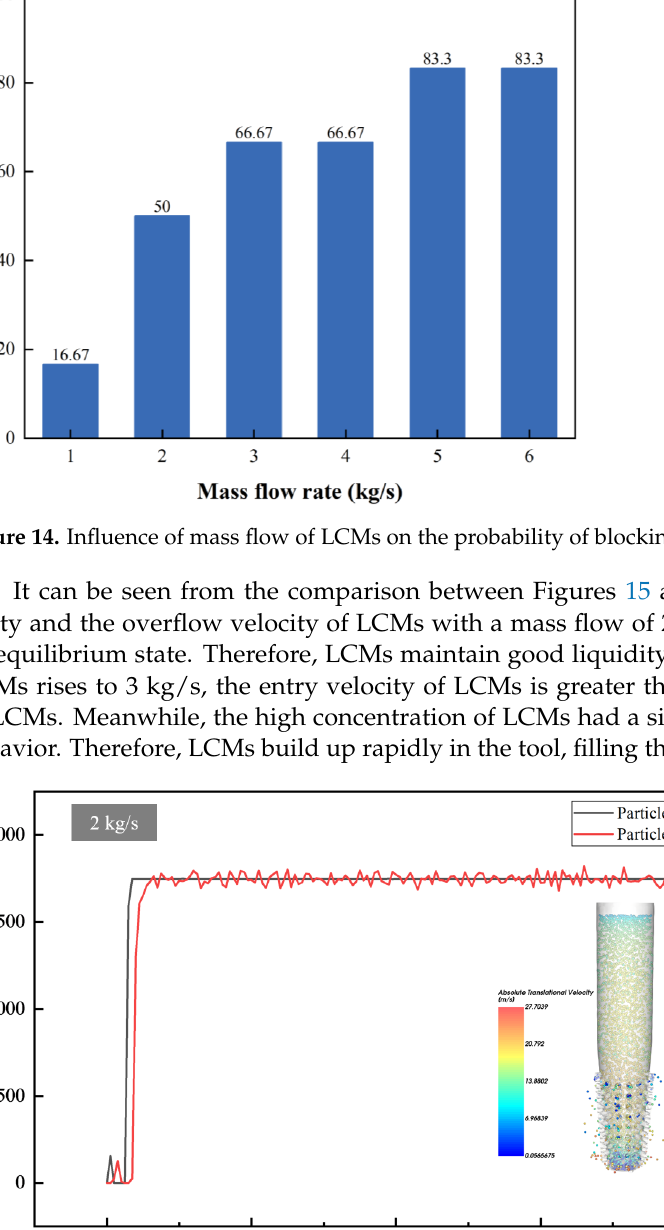
Figure 16. 1.6 mm LCMs entering at 3 kg/s mass flow. 4.4. Influence of Fluid Displacement on Flow Properties Considering the actual working conditions in the drilling process, the displacement of the drilling fluid is different. Therefore, according to the actual parameters, the drilling fluid displacement is divided into three levels: low, medium, and high. The influence of liquid velocity was revealed by comparing the flow properties of materials for plugging while drilling under three types of displacement. Figure 17 shows the displacement ve- locity of LCMs in the whole tool under different displacements of fluid. It can be clearly seen that the overflow rate of LCMs increases with the increase of fluid displacement.